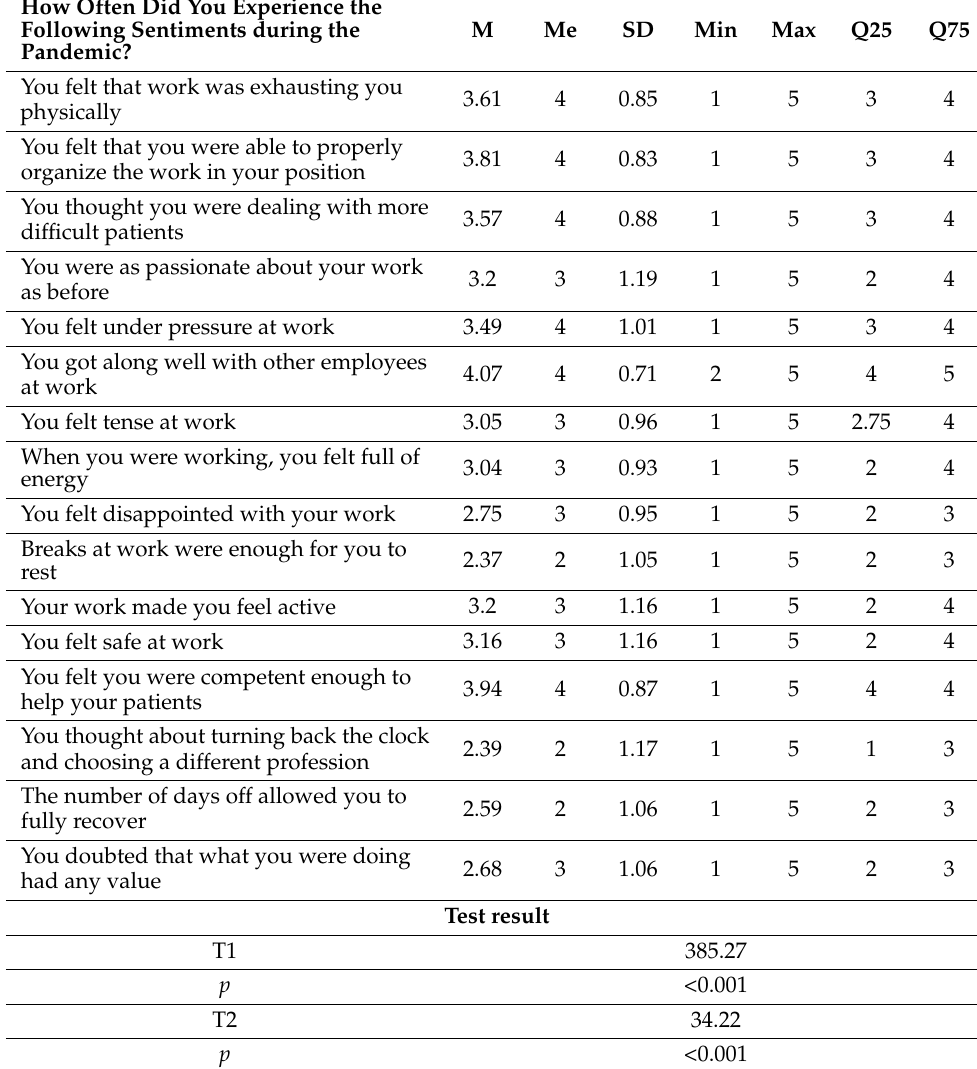
Table 2. Subjective feelings and symptoms reported by the research participants during the epidemic